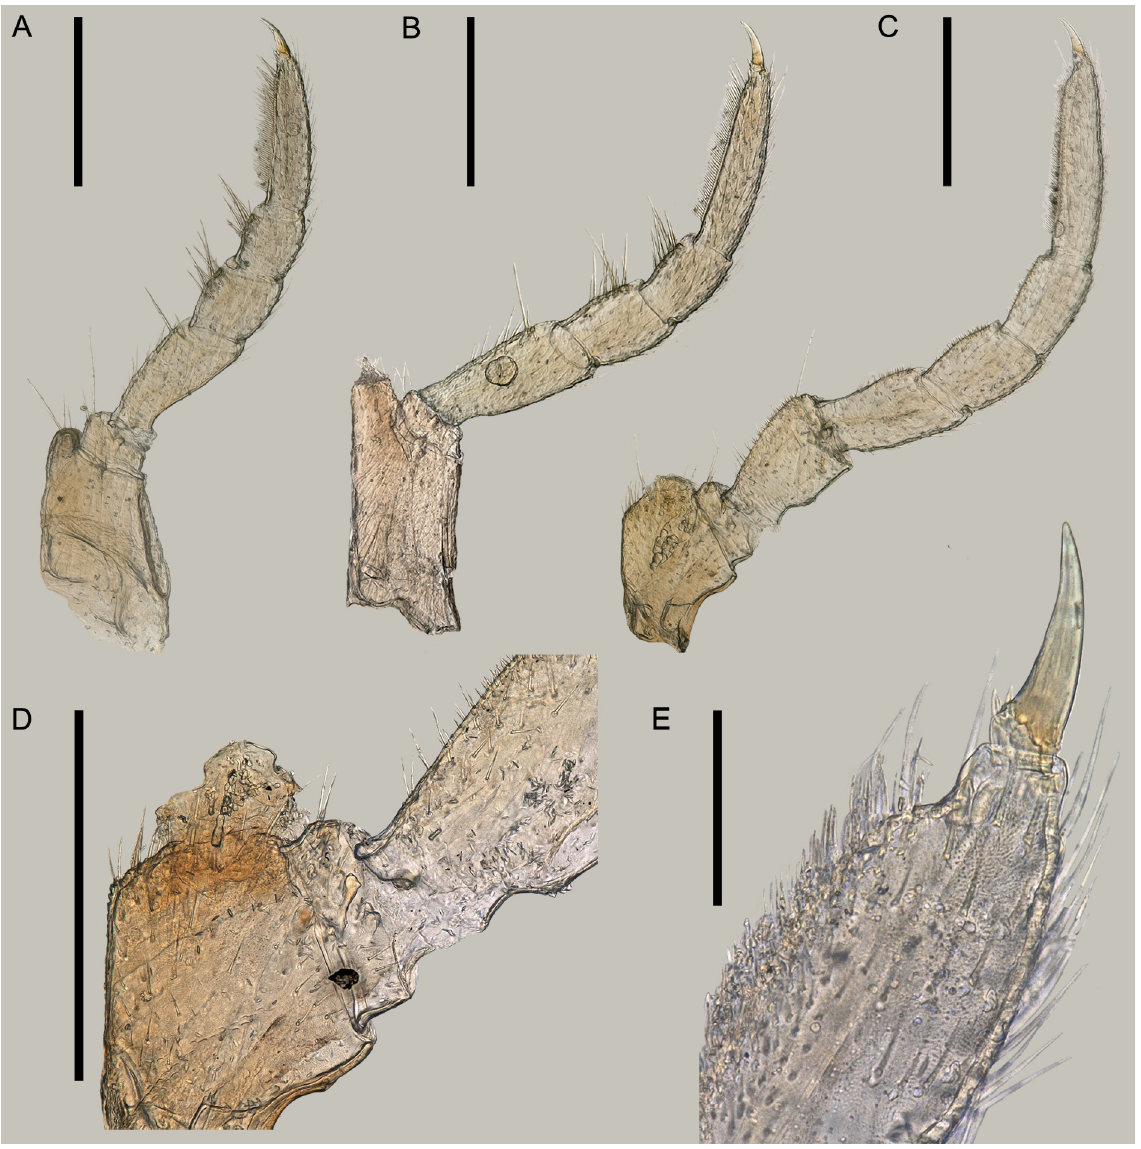
Fig. 4. Legs of ♂ paratype (MNCN 20.07/2071) seen by optic microscopy. A . Leg 1. B . Leg 2. C . Leg 3. D . Coxa and coxal sac of leg 4. E . Tip of tarsus and claw of leg 4. Scale bars: A–D = 0.5 mm, E =0.1